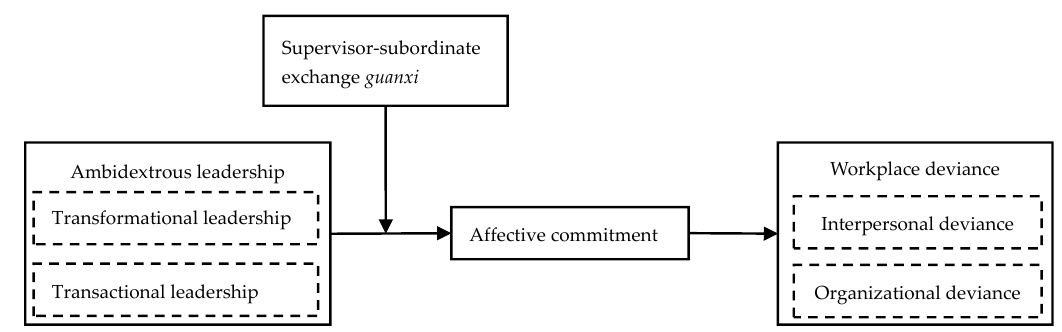
Figure1. Theconceptualmodelofrelationshipbetweenambidextrousleadership, a ff ectivecommitment, supervisor–subordinate exchange guanxi , and workplace deviance Figure 1. The conceptual model of relationship between ambidextrous leadership, affective commitment, supervisor–subordinate exchange guanxi , and workplace deviance behavior.